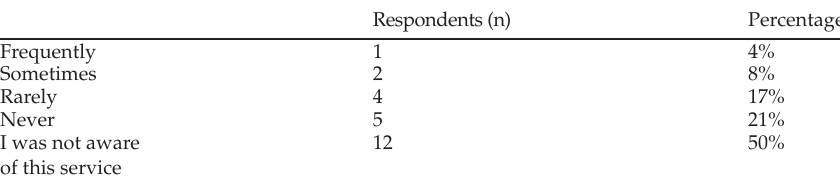
Table 1. Faculty Participation in Collection Development, American University of